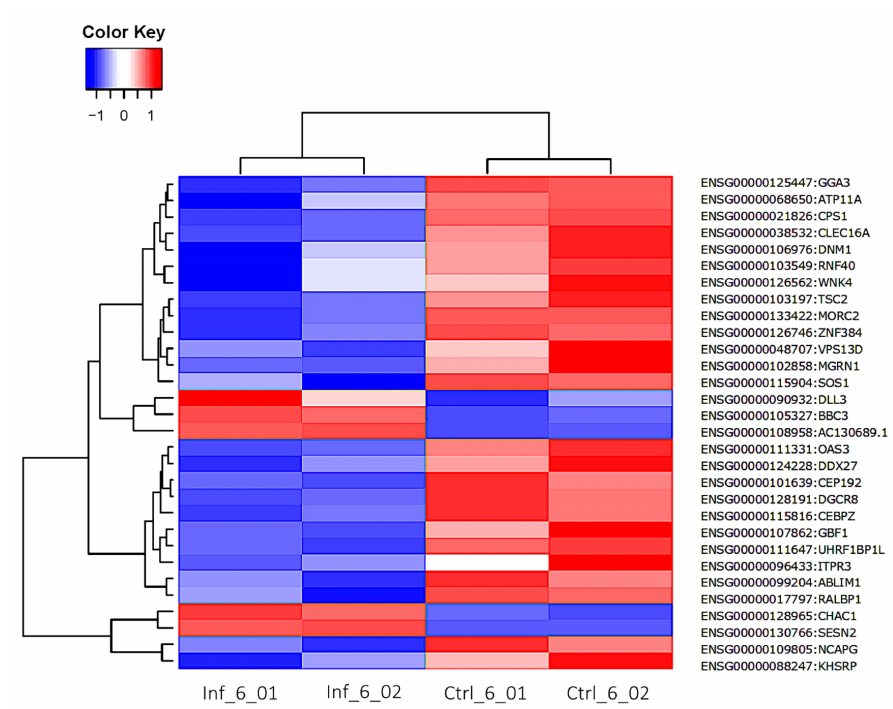
Figure 10. Heatmap generated from the log 2 FC of the top 30 DEGs at 6 hpi. Blue and red colors indicate low and high gene expression, respectively. Gene IDs are indicated on the right side of the heatmap. Columns represent the samples and time points post infection, while rows represent individual genes. The phylogenetic tree above the heatmap shows the hierarchical clustering of the samples. The relationships between the genes are shown on the left tree. For each gene symbol, the respective log 2 FC and other information can be found in Table S2.